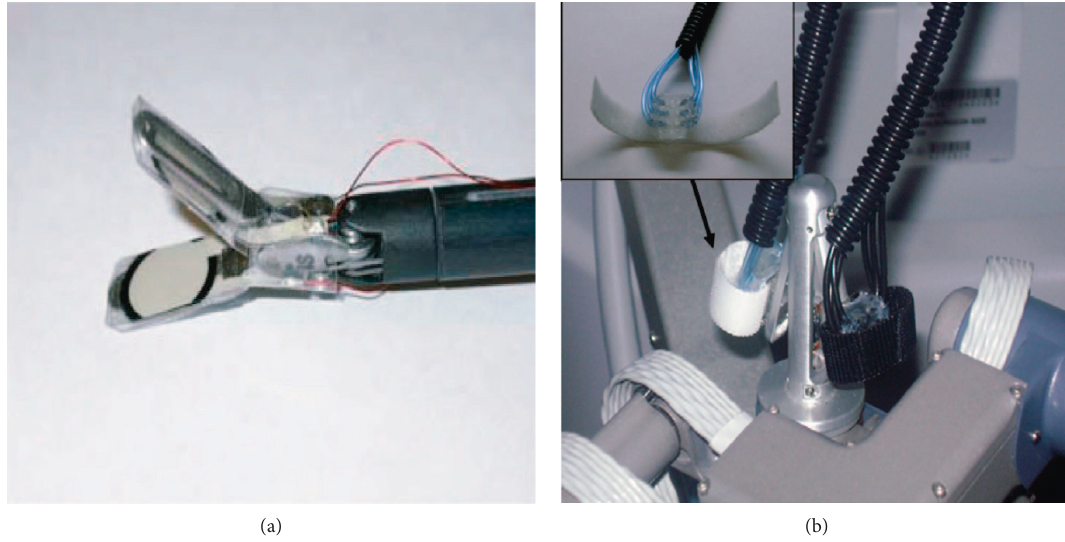
Figure 9: (a) Modified FlexiForce sensor mounted on the top and bottom jaws of the Cadiere grasper for the da Vinci System. (b) The balloon tactile displays were mounted directly onto the da Vinci master control for thumb and index finger (adapted with permission from Ref. [108]; copyright 2009, IEEE publishing